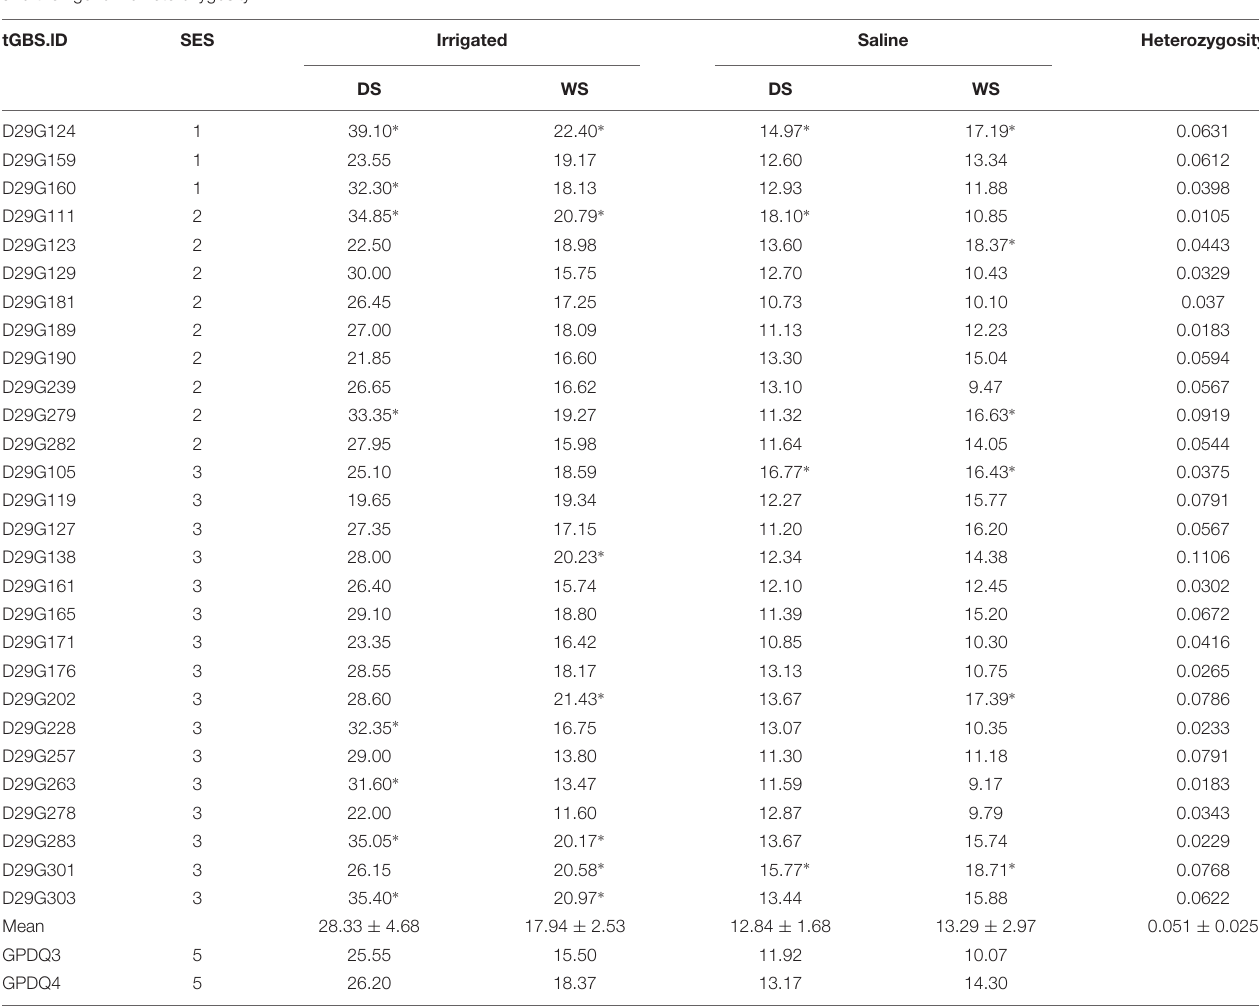
TABLE 2 | The grain yield performances (g/plant) of 28 salt tolerant F 4 lines under normal irrigated and saline conditions in 2016 dry season (DS) and wet season (WS) and their genomic heterozygosity.